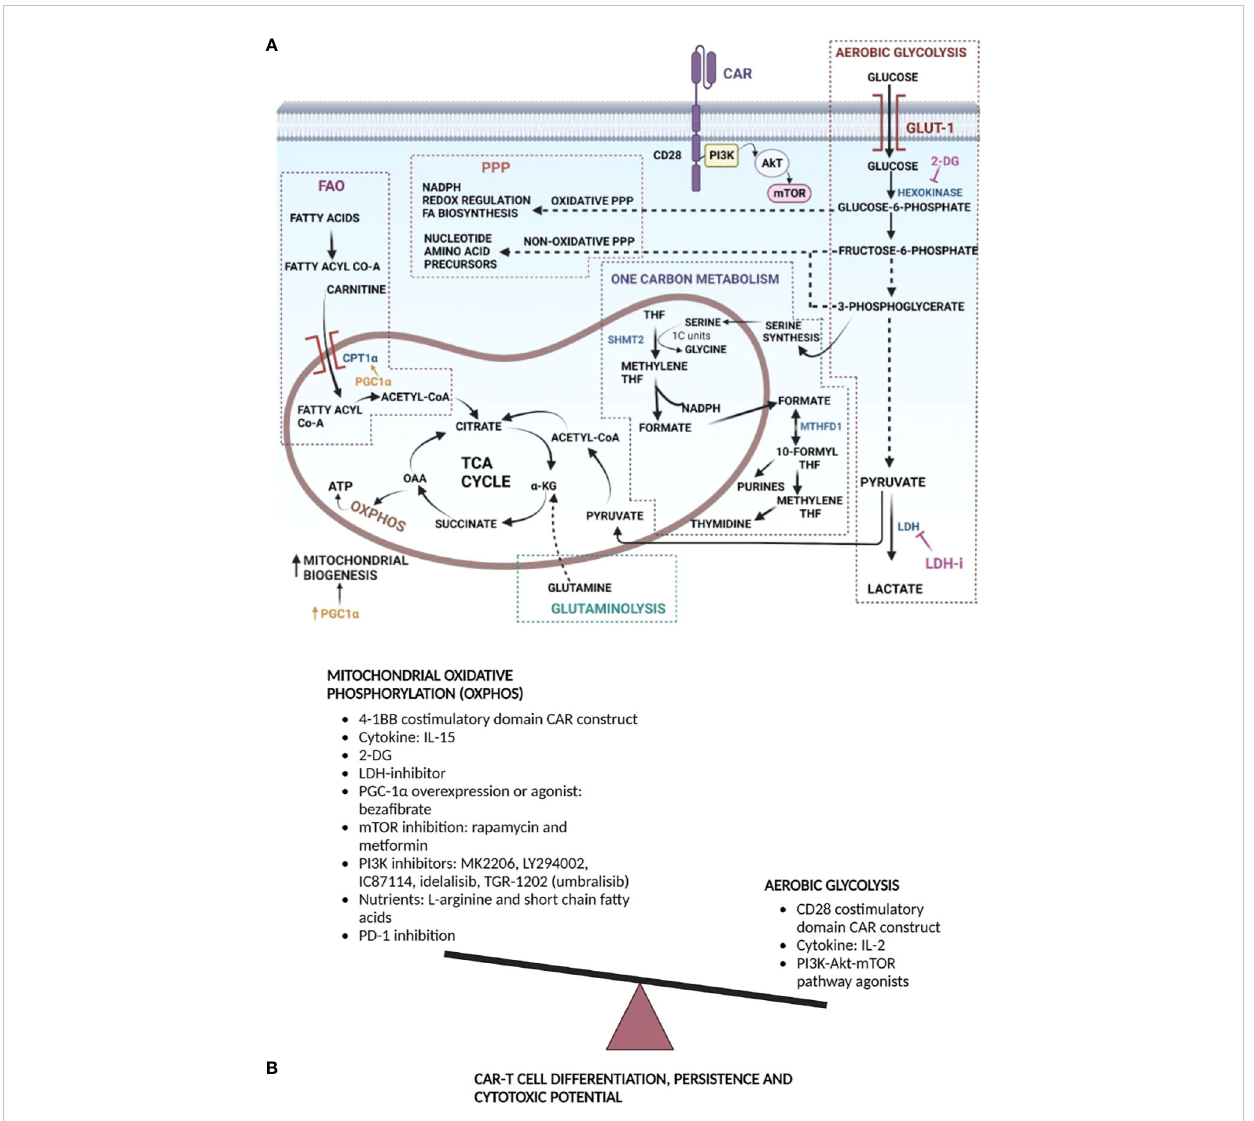
FIGURE 1 Metabolism manipulation strategies to improve CAR T cell ef fi cacy and persistence: (A) T cells undergo metabolic rewiring upon encountering antigen. Aerobic glycolysis is upregulated upon T cell activation. Glycolysis provides energy for cell effector functions, as well as intermediates for the PPP that generates NADPH for anabolic processes and fuels nucleotide and amino acid biosynthesis. Proliferating T cells also rely on serine- glycine, folate, and methionine metabolism to generate one carbon units for de novo nucleotide synthesis, as well as NADPH production. Pyruvate produced at the end aerobic glycolysis can enter mitochondria for conversion to Acetyl CoA that feeds into the TCA cycle. Jointly, within the mitochondria, the TCA cycle, fatty acid oxidation, and glutaminolysis fuel T cell proliferation and differentiation. T cell activation is facilitated by increased mitochondrial biogenesis, generation of energy, OXPHOS and generation of reactive oxygen species, with NADPH providing reducing power for the latter. Potential metabolic points of stimulation or inhibition for enhancing CAR T cell function are provided. 2-DG inhibits hexokinase, re-directing metabolites toward PPP and OXPHOS. Inhibition of LDH drives pyruvate toward TCA and OXPHOS. PGC1 a stimulates mitochondrial biogenesis, which promotes OXPHOS, and can stimulate FAO via CPT1 a . (B) Generally, a memory like CAR T phenotype has been shown to improve in vivo persistence and anti-tumor function. Memory cells primarily rely on OXPHOS; hence, strategies that favor the former during CAR design, CAR T manufacture, expansion, or following infusion are provided. Mitochondrial OXPHOS can be increased directly or indirectly by decreasing aerobic glycolysis. Acronyms used: GLUT-1, glucose transporter-1; 2-DG, 2-deoxyglycose; LDH, lactate dehydrogenase; LDHi, lactate dehydrogenase inhibitor; a -KG, a -ketoglutarate; OAA- oxaloacetic acid; TCA Cycle, tricarboxylic acid cycle; THF, tetrahydrofolate; 1C, one carbon; SHMT2,